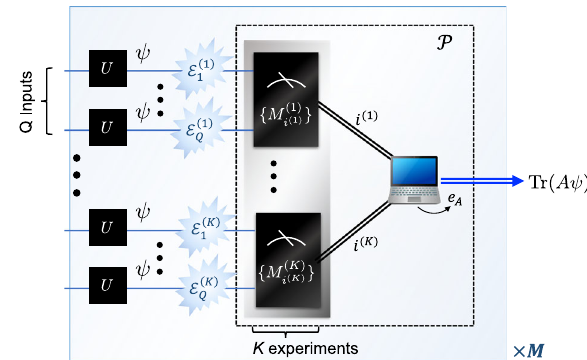
Fig. 2 Schematic of a ( Q , K )-error mitigation protocol. A ( Q , K )-error mitigation protocol is motivated when practical considerations limit the maximum number of distorted states that our mitigation process P can coherently interact to Q . A general approach then divides these into K = ⌈ N / Q ⌉ groups of size Q . To estimate 〈 A 〉 of some ideal output state ψ , each round of ( Q , K )-mitigation involves fi rst using available NISQ devices to generate Q copies of each distorted states E ð k Þ ð ψ Þ , for each of k = 1, … K . These distorted states q Fig. 1 Quantum error mitigation. A A major goal of many near- are then grouped together as inputs into K experiments, where each term algorithms is to estimate the expectation value of some ψ Þ . The k th group consists of a single copy of each E ð k Þ q ð observable A , when acting on the output ψ of some idealized computation U applied to some input ψ in . B However, noise prevents the exact synthesis of ψ . Quantum error-mitigation protocols assist to estimate the true expectation value h A i ¼ Tr ð A ψ Þ without using the adaptive quantum operations necessary in general error correction. This is done by (1) using available NISQ devices to and (2) acting synthesize N distorted quantum states fE n ð ψ Þg N n ¼ 1 some physical process P on these distorted states to produce a random variable E A that approximates A . This procedure can then be repeated over M rounds to draw M samples of E A , whose mean is used to estimate 〈 A 〉 . C We can characterize the ef fi cacy of such protocol by (1) its spread Δ e A , the difference between maximum and minimum possible values of E A and (2) the bias b A ð ψ Þ ¼ E A h i (cid:2) h A i . Here we derive ultimate lower bounds on Δ e A for each given bias that no such error-mitigation protocol can exceed, as well as tighter bounds when P is restricted only to coherent interactions over Q noisy devices at a time. This then tells us how many times P must be executed to estimate 〈 A 〉 within some desired accuracy and failure probability.